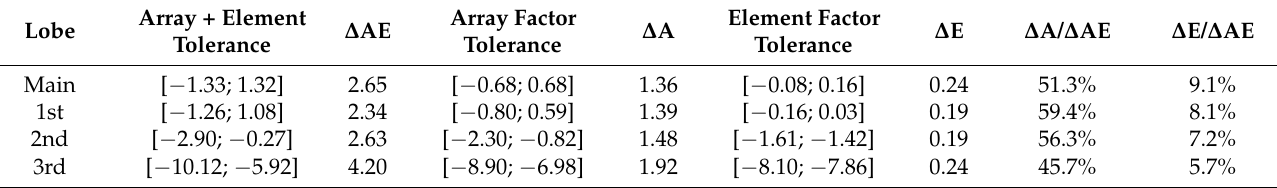
Table 8. SLL interval value in Figure 26 (10 × 10